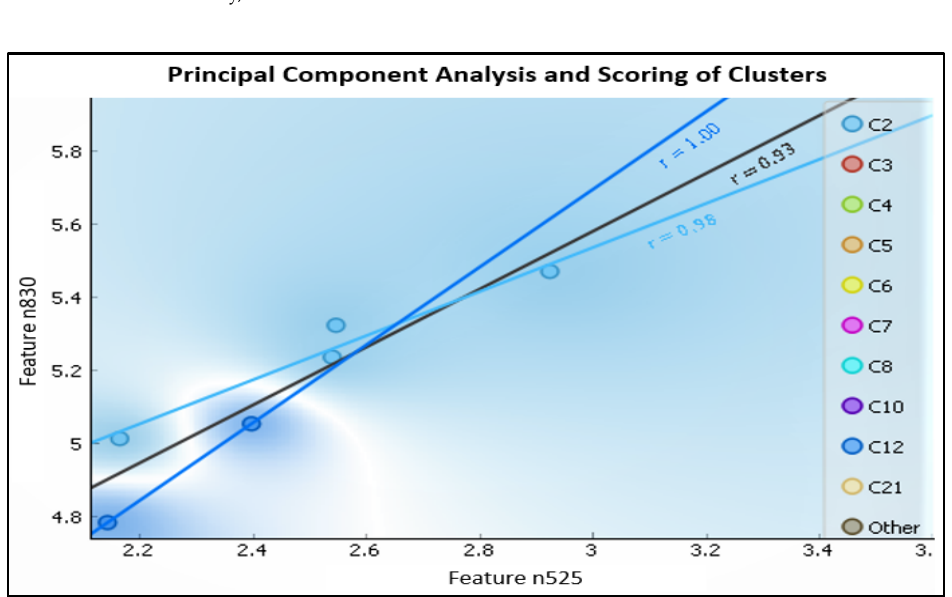
Figure 10. Features-based Principal Component Analysis and scoring of clusters. Features n525 and n830 are indicated on the X- and Y-axes, respectively. The clusters are colour coded, and the colour of each regression line on the graph matches the colour on the cluster legend on the right.